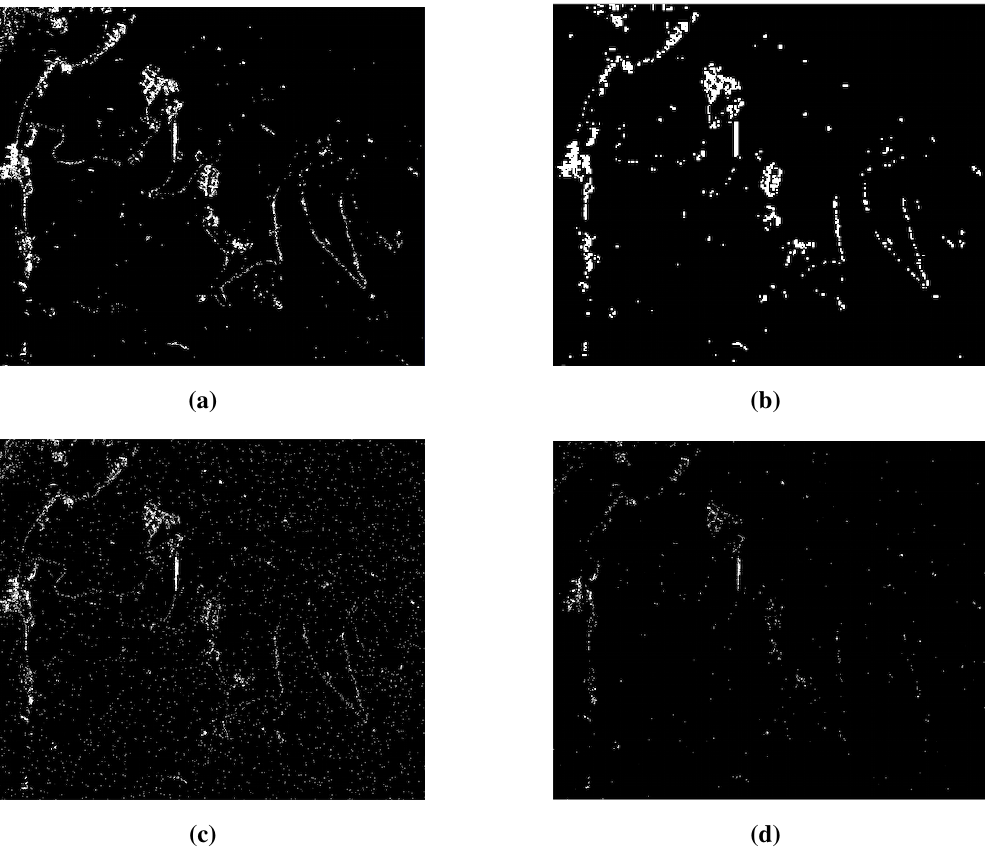
Figure 11. Pixel candidates selected using ( a ) the TSC with a threshold of 0 . 82 ; ( b ) the coherence stability with a threshold of 0 . 65 ; and the D ( d ) of 0 . 15 for the TerraSAR-X